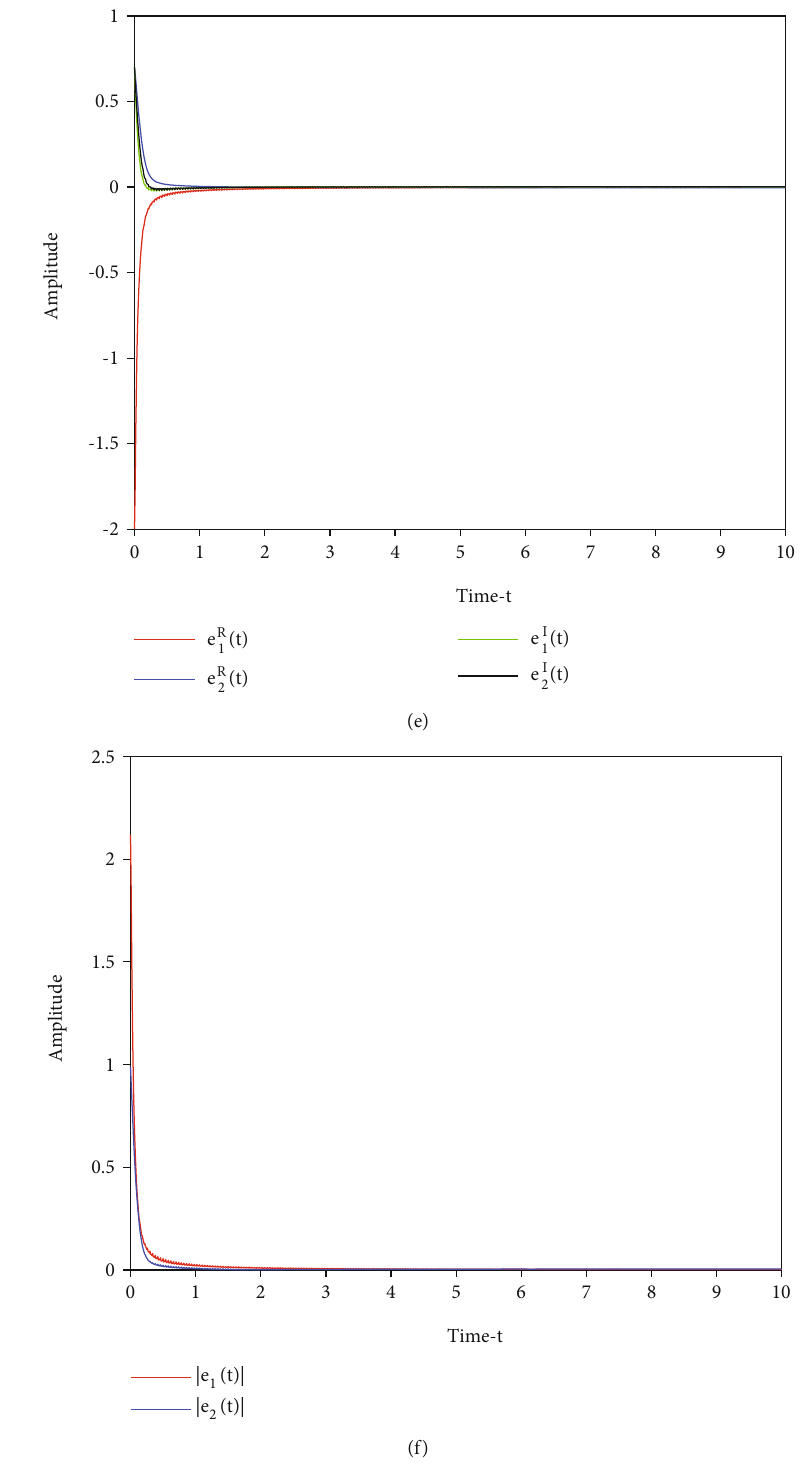
Figure 3: (a, b) The real parts of synchronization state trajectories with controller (42). (c, d) The imaginary parts of synchronization state trajectories with controller (42). (e) The error trajectories with controller (42). (f) The error modulus trajectories with controller